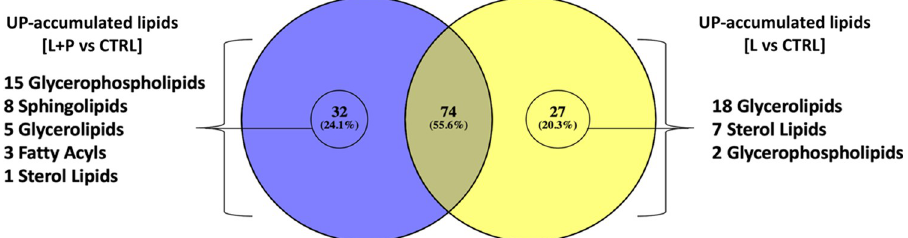
Fig 4. Venn diagram considering the significant (p < 0.05) and UP-accumulated lipid subclasses following both L +P vs CTRL (purple color) and L vs CTRL (yellow color) pairwise comparisons.